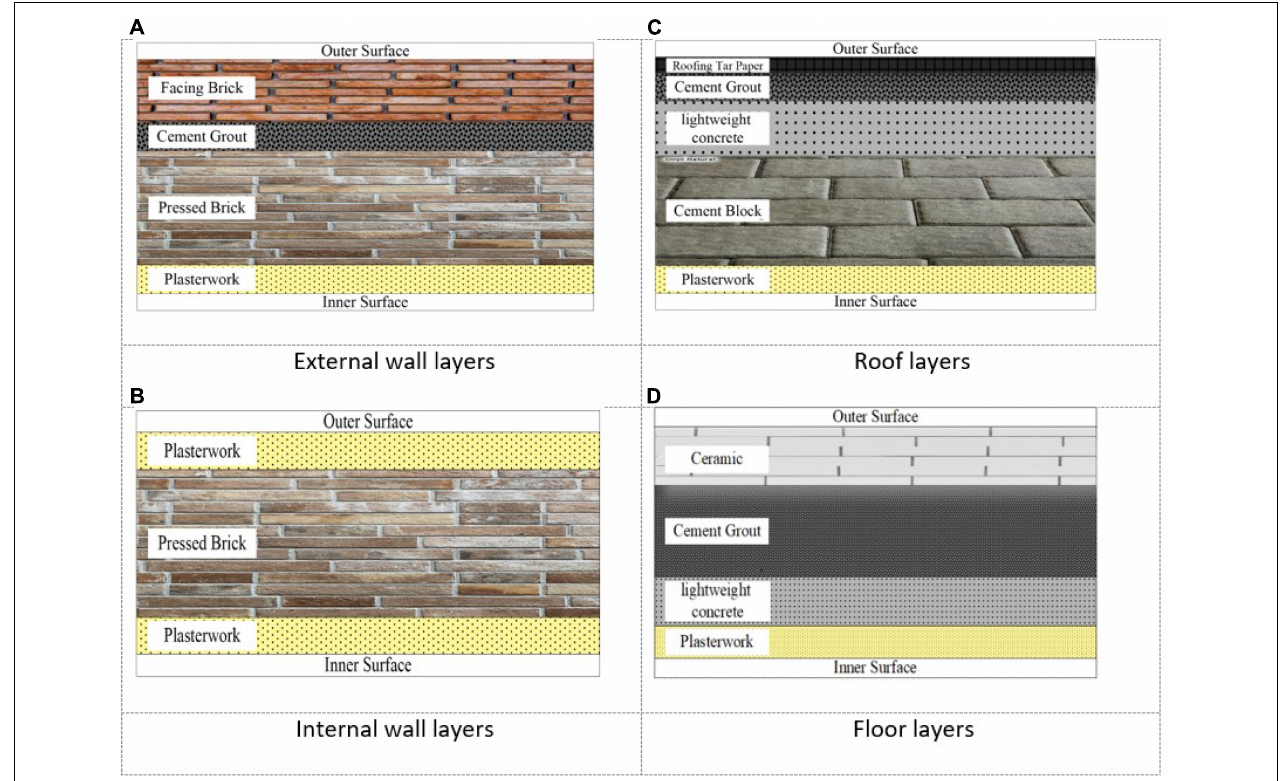
FIGURE 4 | Building wall layers and materials. (A) External wall layers. (B) Internal wall layers. (C) Roof layers. (D) Floor layers.